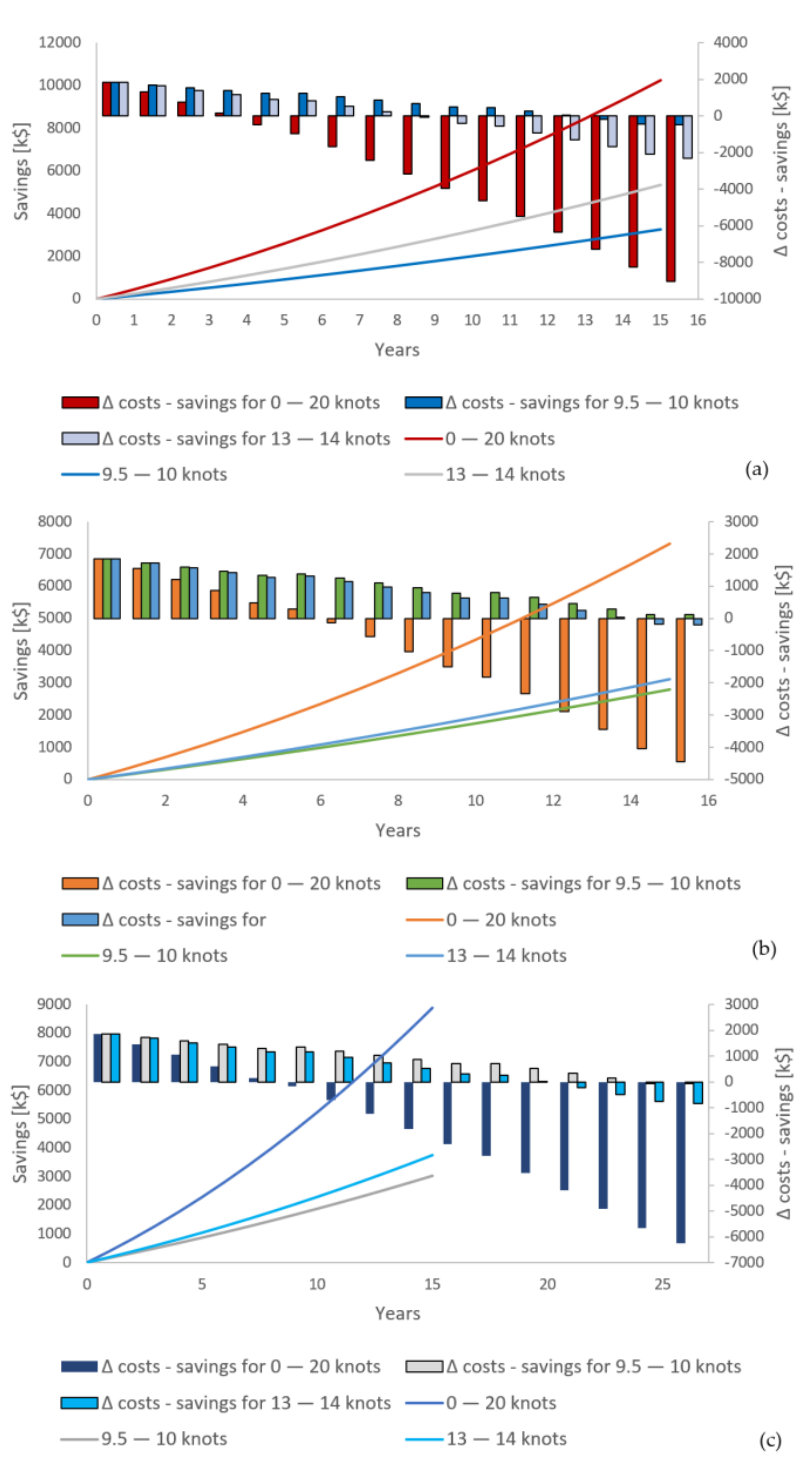
Figure 17. 6DOF simulation for a route from Tokyo to Sidney in different rotor configurations: ( a ) D = 5 m and AR = 6; ( b ) D = 3 m and AR = 8; ( c ) D = 3 m and AR = 6.